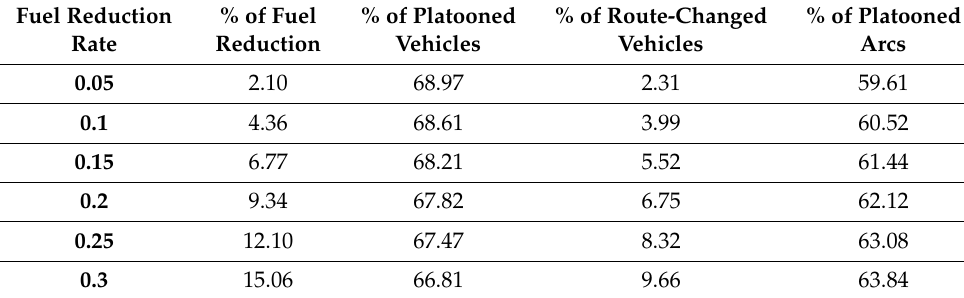
Table 7. Performance for different fuel reduction rates.